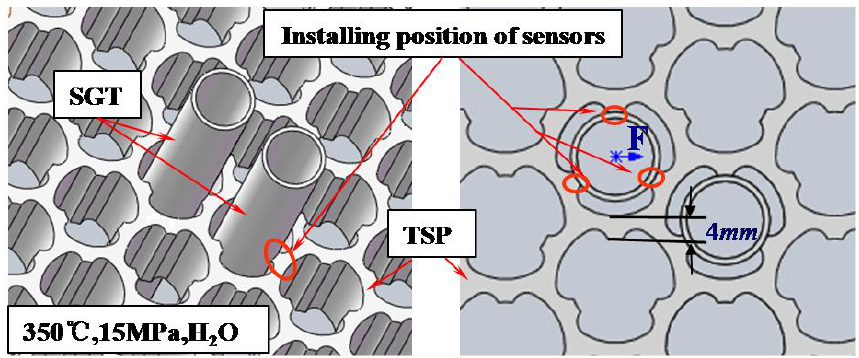
Figure 1. Schematic structure of steam generator tube (SGT) and tube support plate (TSP) and installing position of force sensor.